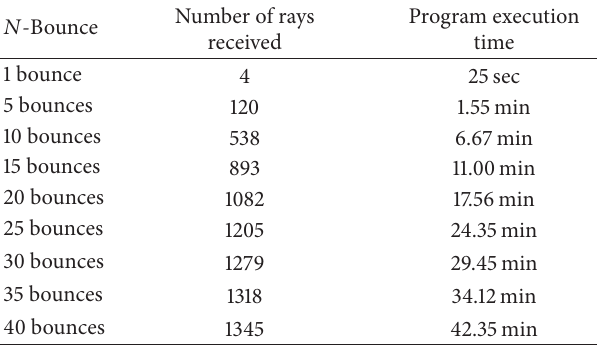
Table 1: Rays reaching receiver cumulatively up to 𝑁 -bounce and the execution time (4126183 rays are launched) in Intel Core Duo CPU, 3 GHz, and 4GB RAM.